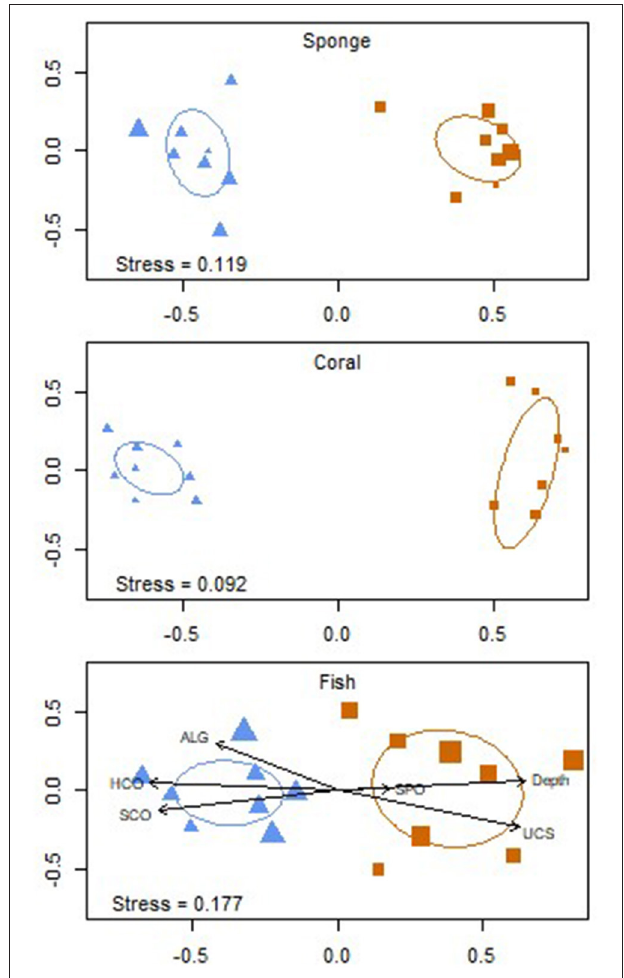
FIGURE 5 | Non-metric multidimensional scaling (NMDS) plots of the sponge, coral, and fish assemblages surveyed at 16 sites (8 at 20m and 8 at 45m depths) at the Guánica shelf edge along the southern coast of Puerto Rico. Distances calculated using Bray-Curtis similarities. Ellipses represent 1 standard deviation. Site characters scaled to goodness of fit (GOF). GOF ranges: Sponge [20m (0.015–0.040), 45m (0.024–0.04)], Coral [20m (0.016–0.023), 45m (0.016–0.034)], Fish [20m (0.028–0.051), 45m